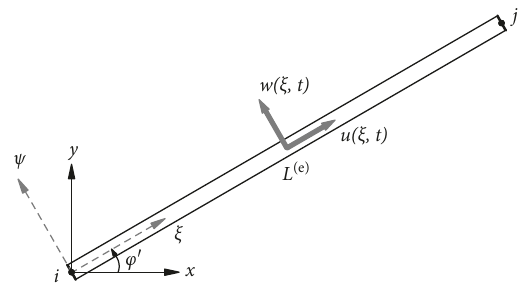
Figure 4: Global and local coordinate systems and DOFs, where ( L ) (e) denotes the element